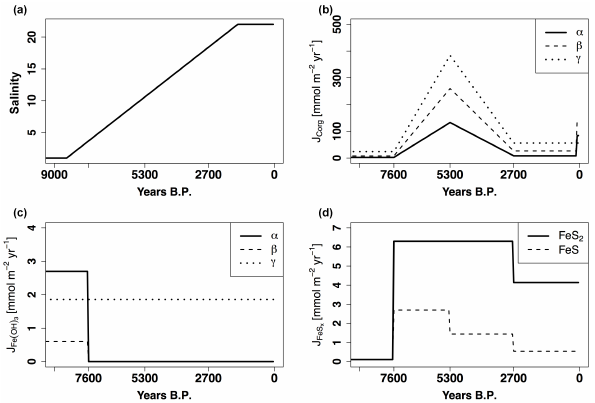
Figure 2. Transient evolution of salinity with a linear increase from 1 to 22 between 8500 and 1500 years B.P. (a) , fluxes of organic ); (c) and Fe sulfides ( J FeS ); (b) Fe oxides ( J Fe(OH) matter ( J C org 3 (d) as implemented in the diagenetic model (site